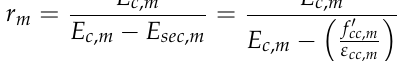
Figure 7. Fitting results for the elastic modulus of concrete considering the combined action of Freeze–thaw and chloride-induced corrosion.